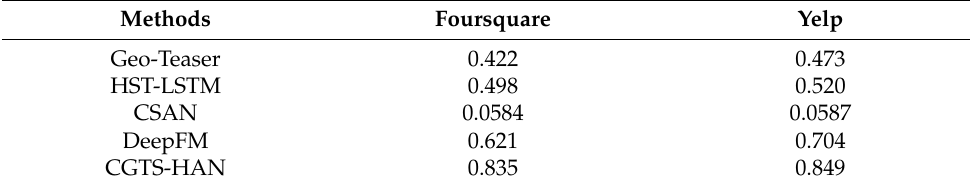
Table 3. Experimental Results of